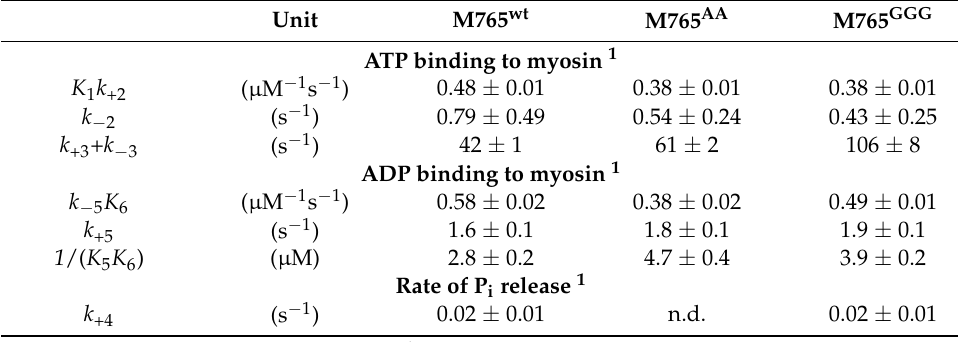
Table 3. Transient kinetic parameters and equilibrium constants in the absence of actin.